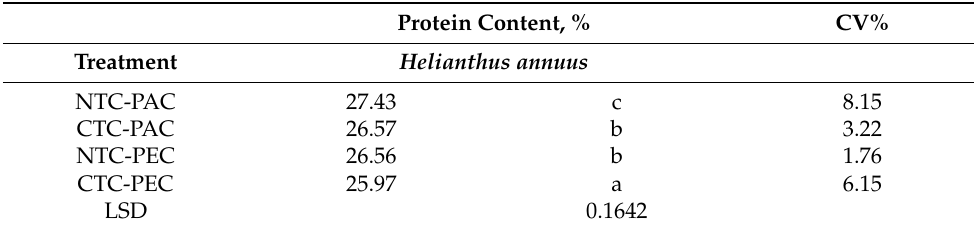
Table 3. Protein content (%) of the Helianthus annuus cultivation in the 4 different soil practice treatments in the first growing year.